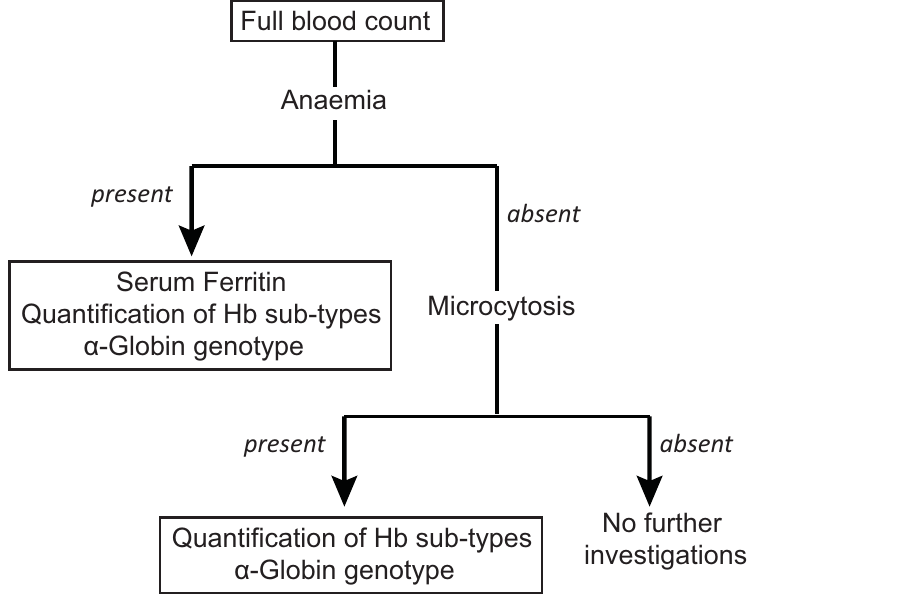
Fig 1. Flow diagram showing investigation